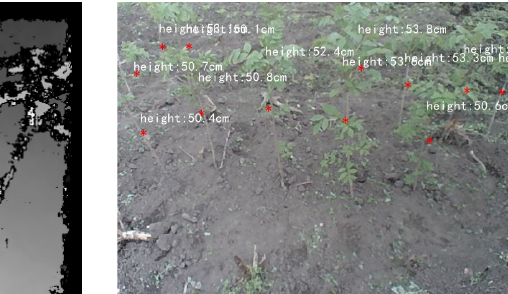
Figure 9. Manchurian ash saplings’ detection images.